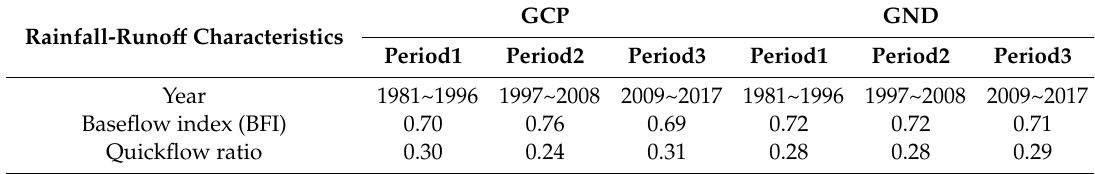
Table 6. Rainfall-runo ff characteristics in the rainy season of each period in the GCP and GND forest